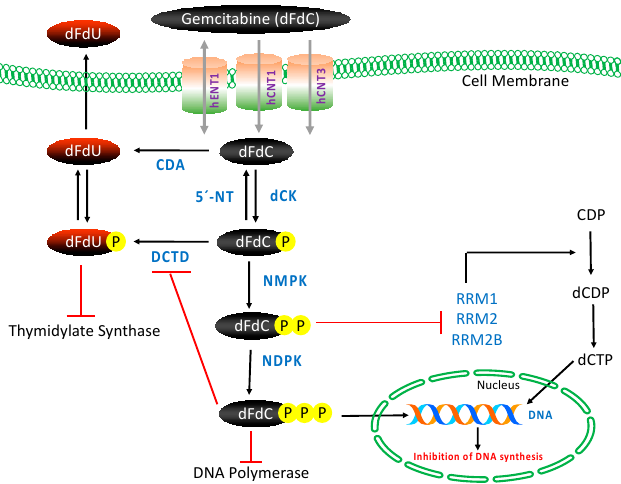
Figure 2. Gemcitabine: transport, intracellular activation/deactivation and mechanism of